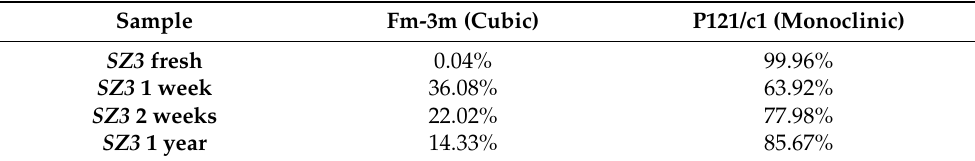
Table 2. The proportion of zirconia crystalline phases in core@shell NPs as a function of age. Sample